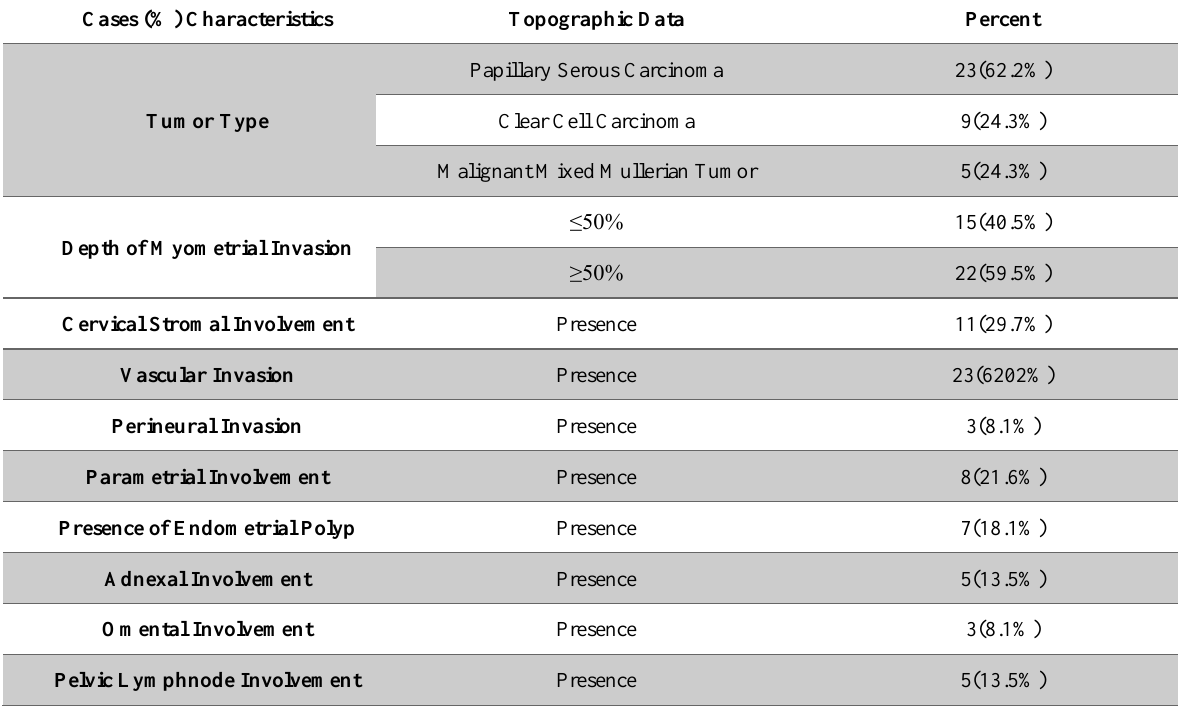
Table 1. Topographic characteristics of patients and tumors Cases (%)